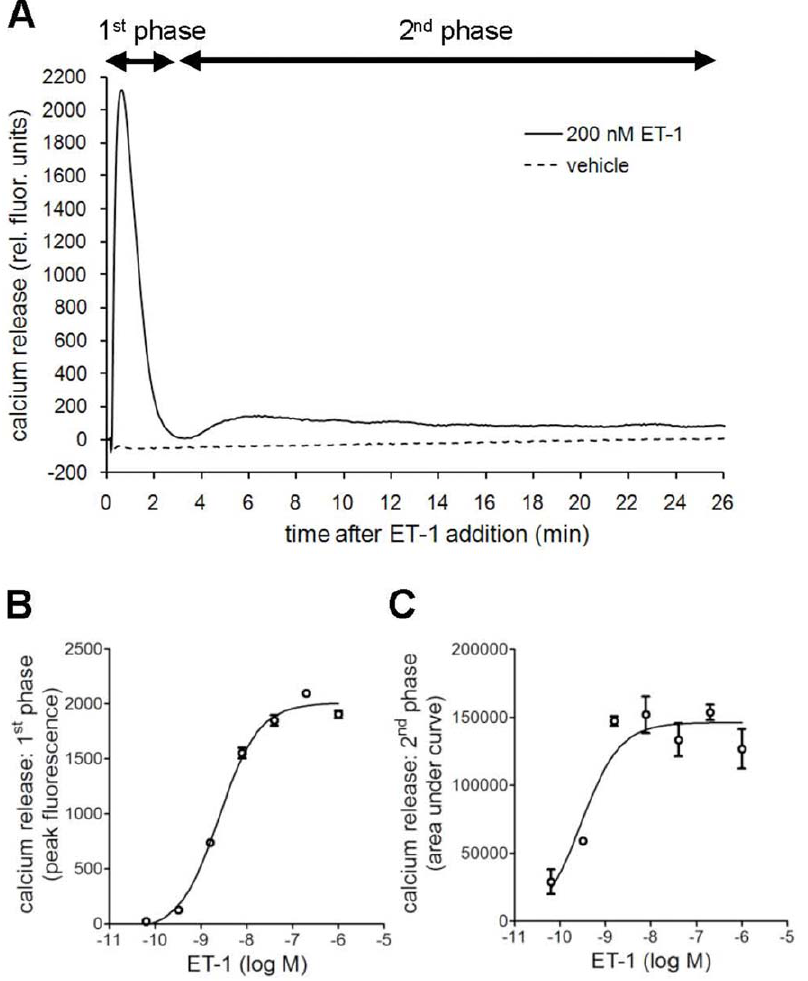
Figure 6. Characterization of the biphasic intracellular calcium response to ET-1 in PASMC. Cells were stimulated with a dilution series of ET-1 and the biphasic calcium response was recorded for 25 minutes. Shown are the raw FLIPR fluorescence traces for 200 nM ET-1 and vehicle treatment covering the first transient response phase and the second sustained response phase (A), the concentration-response-curves of ET-1 obtained for the first phase using peak fluorescence values + / 2 SD of duplicates (B) and the concentration-response-curves of ET-1 obtained for the second phase using area under the curve values between 3 min and 23 min after stimulation + / 2 SD of duplicates (C).